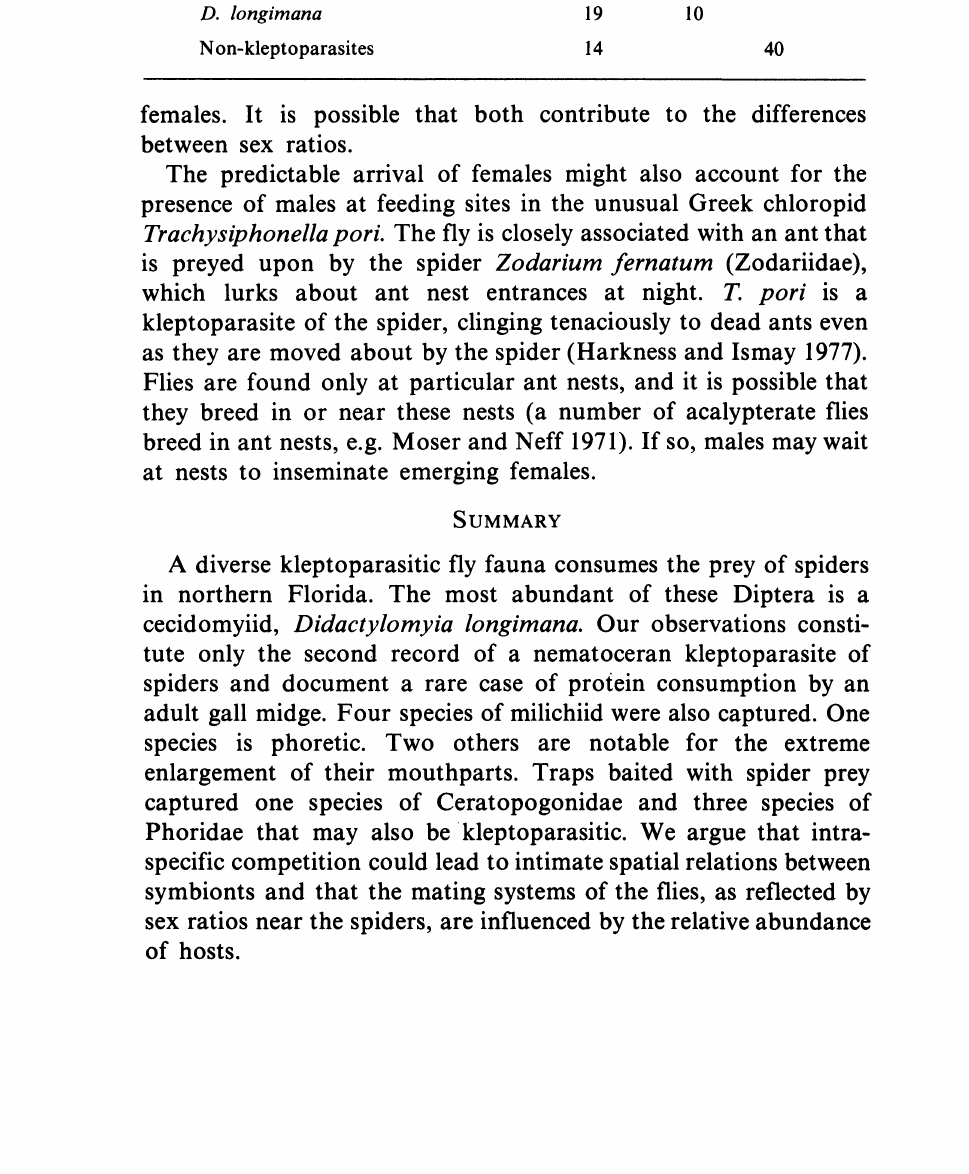
Table 1. The sex ratio of Didactylomyia longimana compared to that of 6 species of non-kleptoparasitic cecidomyiids hanging in the same webs, chi-square 10.25, p<.005. The difference in sex ratios may be the result of D. longimana males waiting near sites likely to attract females. Alternatively, female kleptoparasites may search for food and spend less time in webs than either males of their own species or females of non-kleptoparasitic